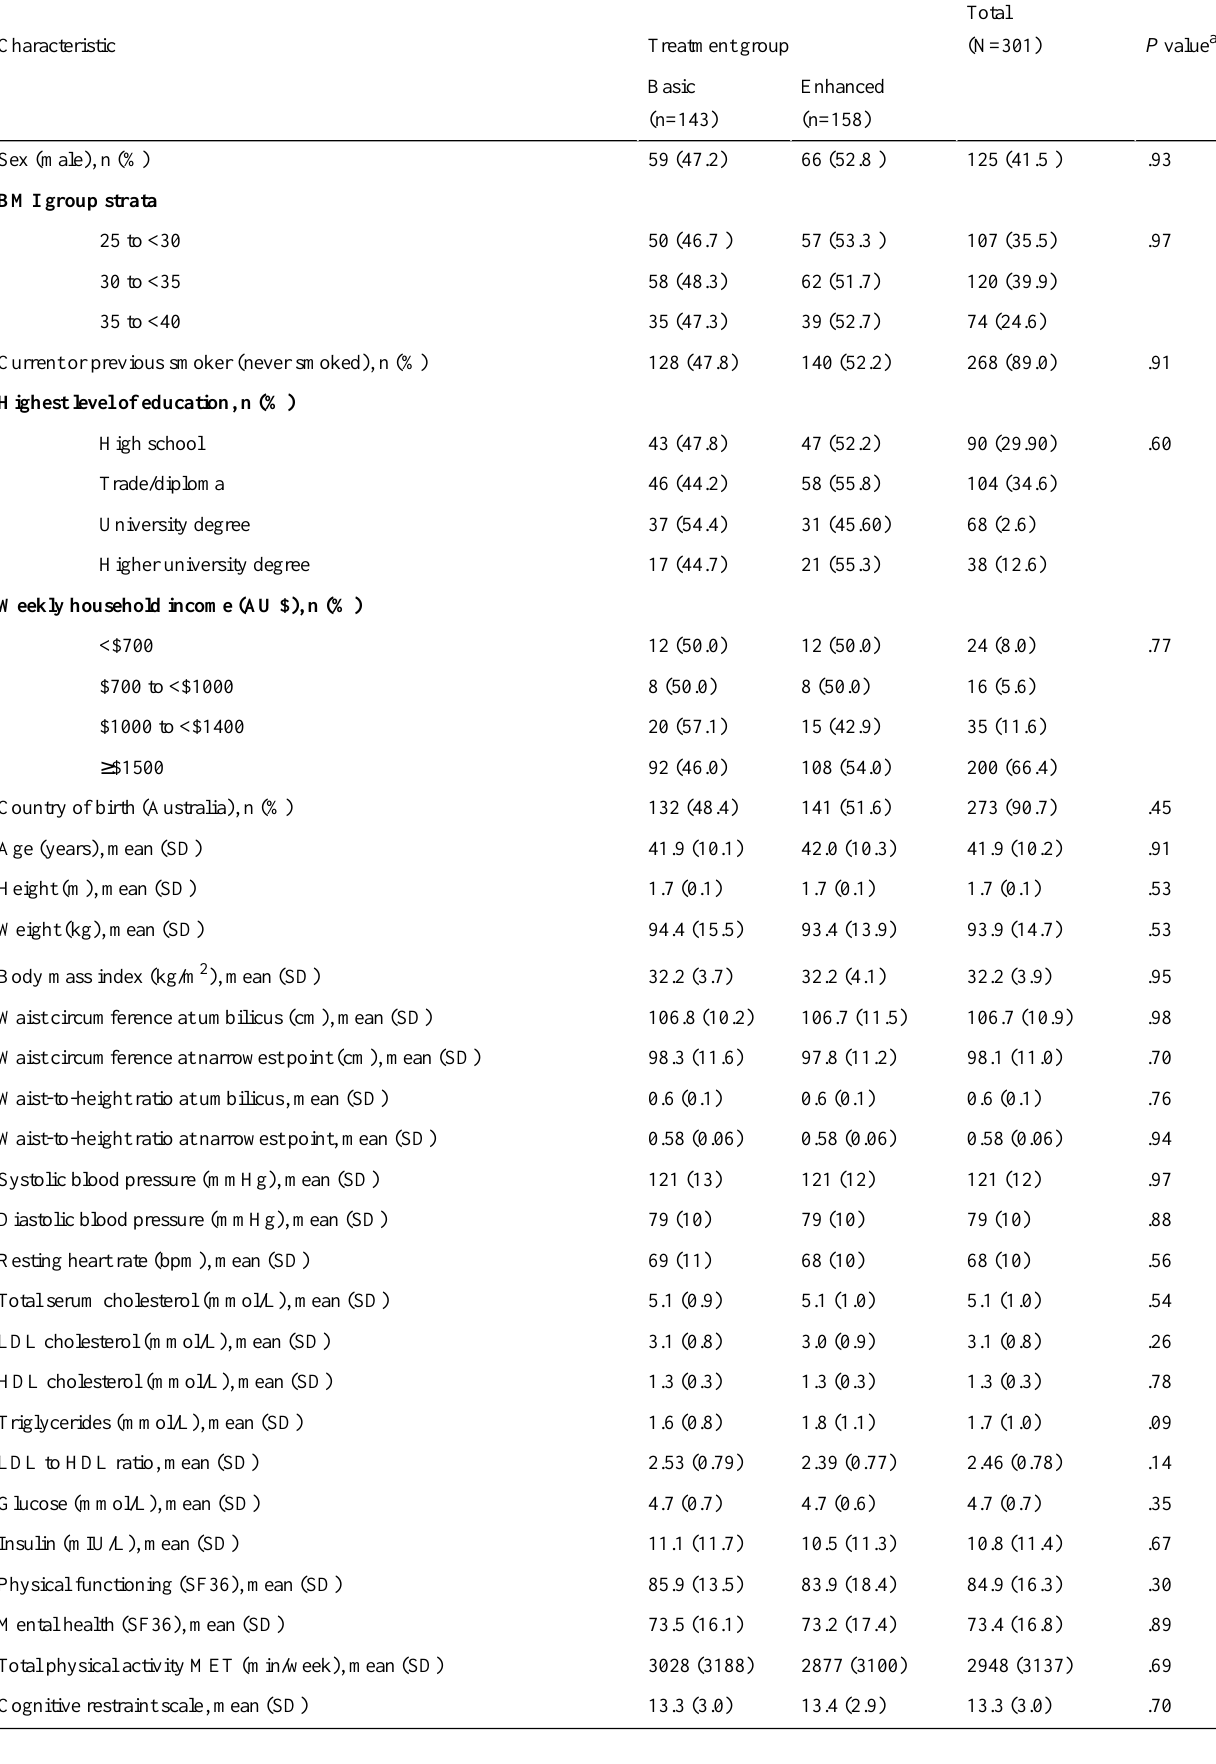
Table 2. Demographic and other baseline characteristics by treatment